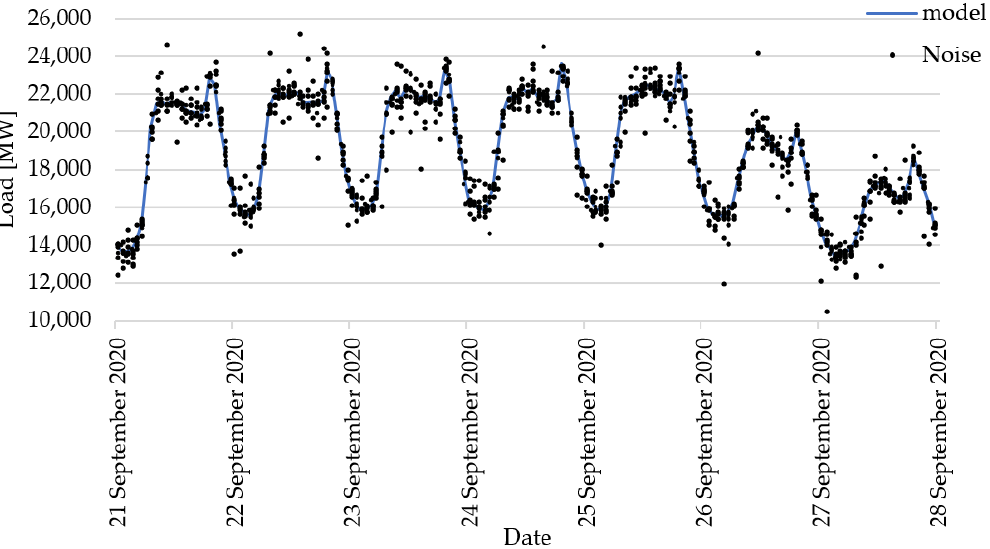
Figure 8. Noise-disturbed load time series. Table 4. Simulation experiment